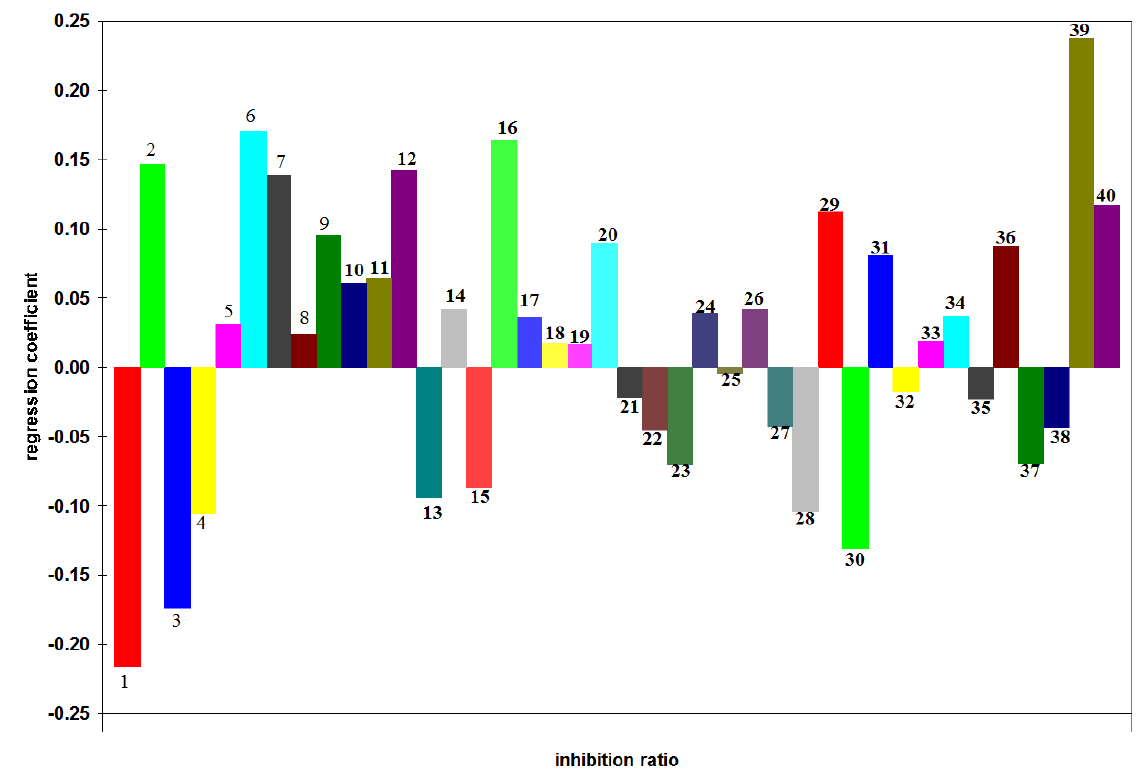
Figure 6: The standardized regression coefficients of inhibition of M. halliana flowers on α-glucosidase activity in